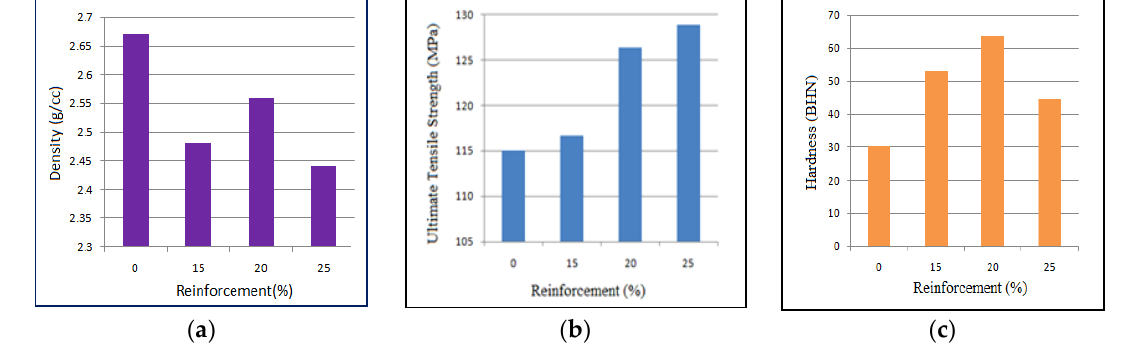
Figure 3. ( a ) Variation of density with reinforcement ( b ) Variation of tensile strength with reinforcement ( c ) Variation of hardness with reinforcement.